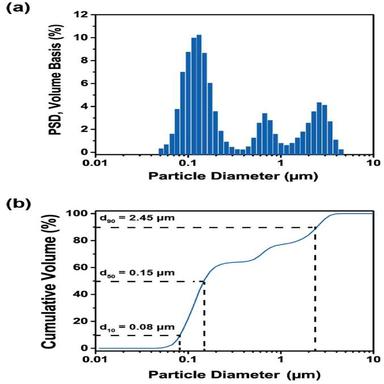
Laser diffraction particle characterization. (a) Particle size distribution and (b) cumulative volume fraction of as-received NiO powder.